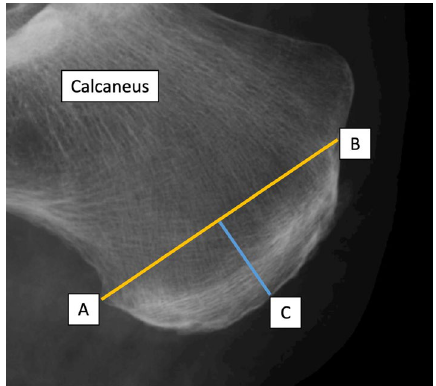
Figure 1. A representative x-ray of the right calcaneus of one specimen is depicted. The midpoint of a line (yellow) drawn from the insertion of the PF into the calcaneus (A) to the insertion of the AT into the calcaneus (B) is where a perpendicular line (blue) was drawn to measure the thickness (C) of the apophysis of the